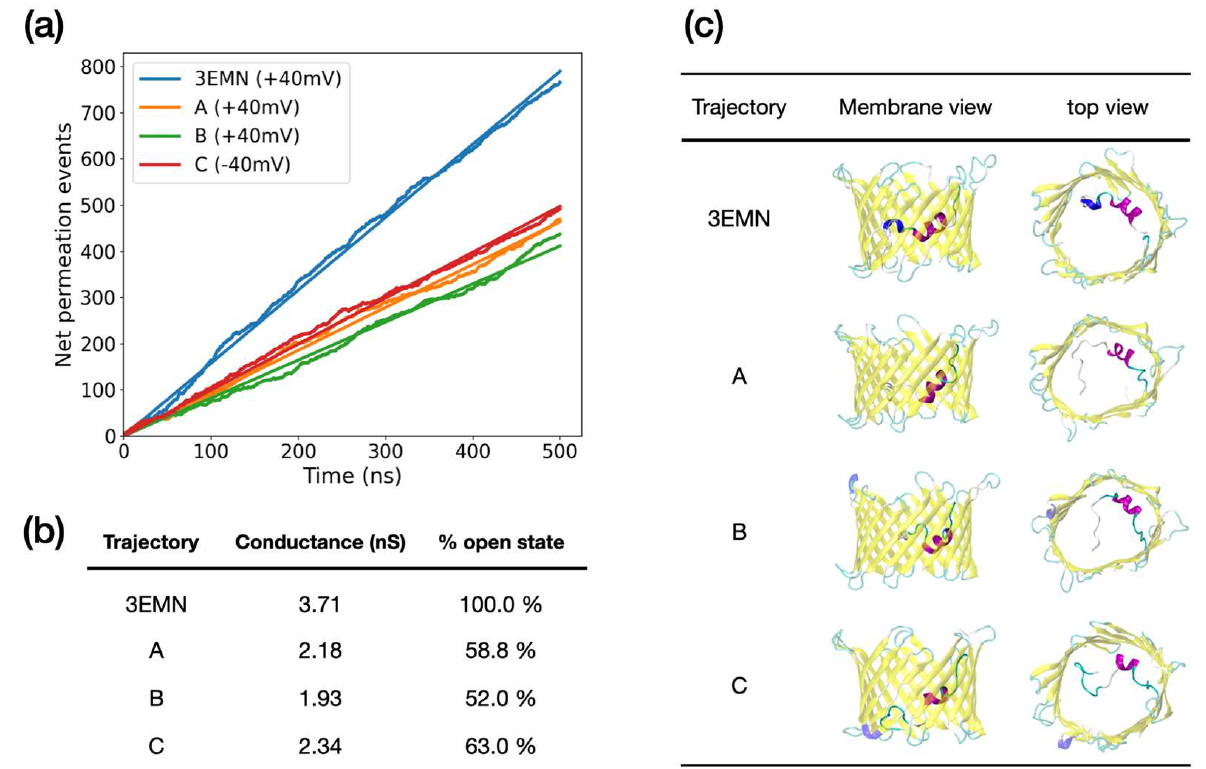
Figure 4. ( a ) Net ion permeation events recorded from unbiased MD simulation at applied voltage. Simulations were initiated from different VDAC1 conformations, namely, 3EMN and 3 conformers obtained from aMD; conformers A and B were sampled at +40 mV and conformer C was sampled at − 40 mV. To be consistent with our initial sampling, applied voltage in unbiased MD was set to +40 mV for 3EMN, A and B, and − 40 mV for C. For each curve, simple linear regression was performed (straight lines), giving an R 2 of 0.99 in all cases. ( b ) Conductance deduced from the slope of the ion permeation curves. The slopes correspond to the electric current, which, after renormalization and division by the applied voltage, provide an estimate of the conductance. ( c ) Average structure of MD trajectories in side view (membrane) and top view.